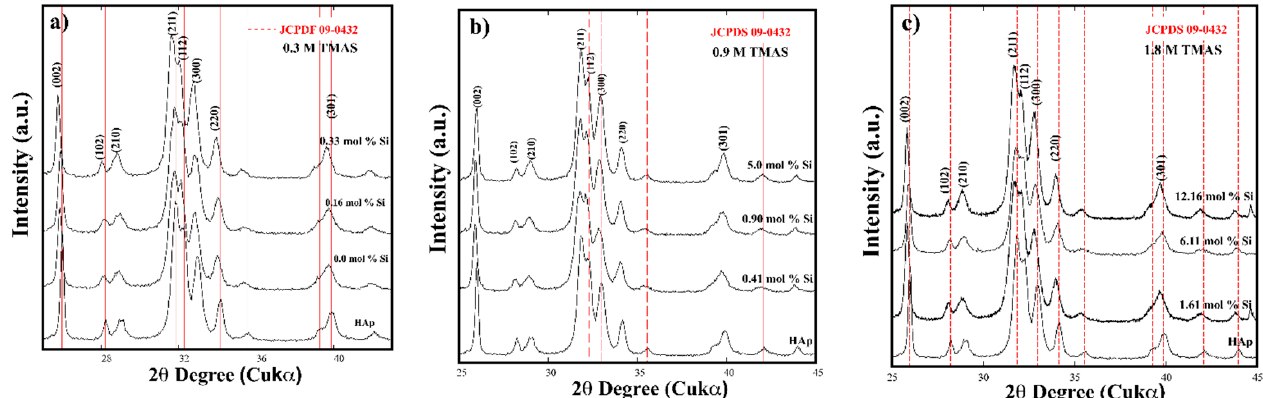
Figure 1. Si-HAp XRD patterns of samples synthesized under microwave-assisted hydrothermal conditions at 150 °C for 1 h, pH = 10, using 0.2 M Na 5 P 3 O 10 with different Si 4+ mol% using (TMAS), which was mixed with a molar excess of ( a ) 1.5 (0.3 M), ( b ) 4.5 (0.9 M), and ( c ) 9 (1.8 M) folds, above the stoichiometric concentration of 0.2 M as shown.